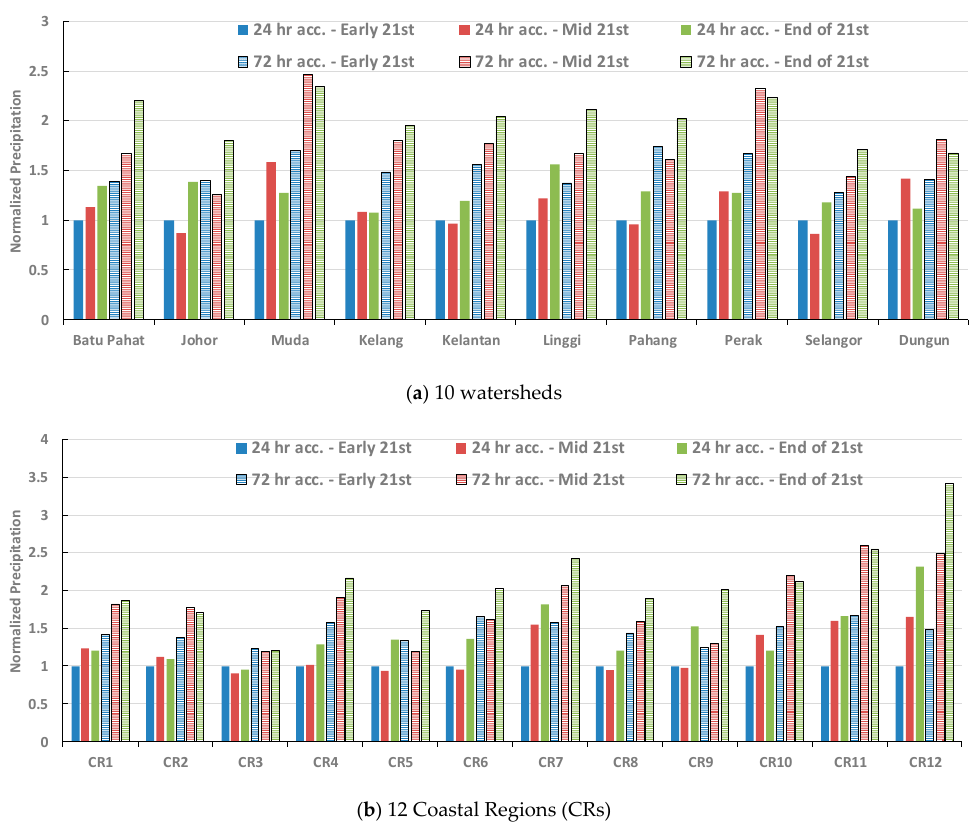
Figure 7. Normalized values of 24-h and 72-h accumulated precipitation for 100-year return period during the early, middle, and end of 21st century for the ( a ) 10 watersheds and ( b ) 12 coastal regions (CRs) of Peninsular Malaysia. Precipitation values are normalized with the 24 h accumulated precipitation value in the early 21st century. ( a ) 10 watersheds; ( b ) 12 Coastal Regions (CRs). The accumulated precipitation values for 100-year return period do not always increase through the 21st century. The 24-h accumulated precipitation values increase through the 21st century in Batu Pahat, and Linggi watersheds, and in CR4, CR7, CR11, and CR12. Similarly, the 72-h accumulated precipitation values increase through the 21st century in Batu Pahat, Kelang, Kelantan, Linggi, and Selangor watersheds, and in CR1, CR4, CR7, CR8, CR9, and CR12. Both 24-h and 72-h accumulated precipitation values are higher in Johor, and Pahang watersheds, and in CR3, and CR5 during the early 21st century as compared to the middle 21st century. They are also higher in Muda, Perak, and Dungun watersheds, and in CR2, and CR10 during the middle 21st century as compared to the end of 21st century.